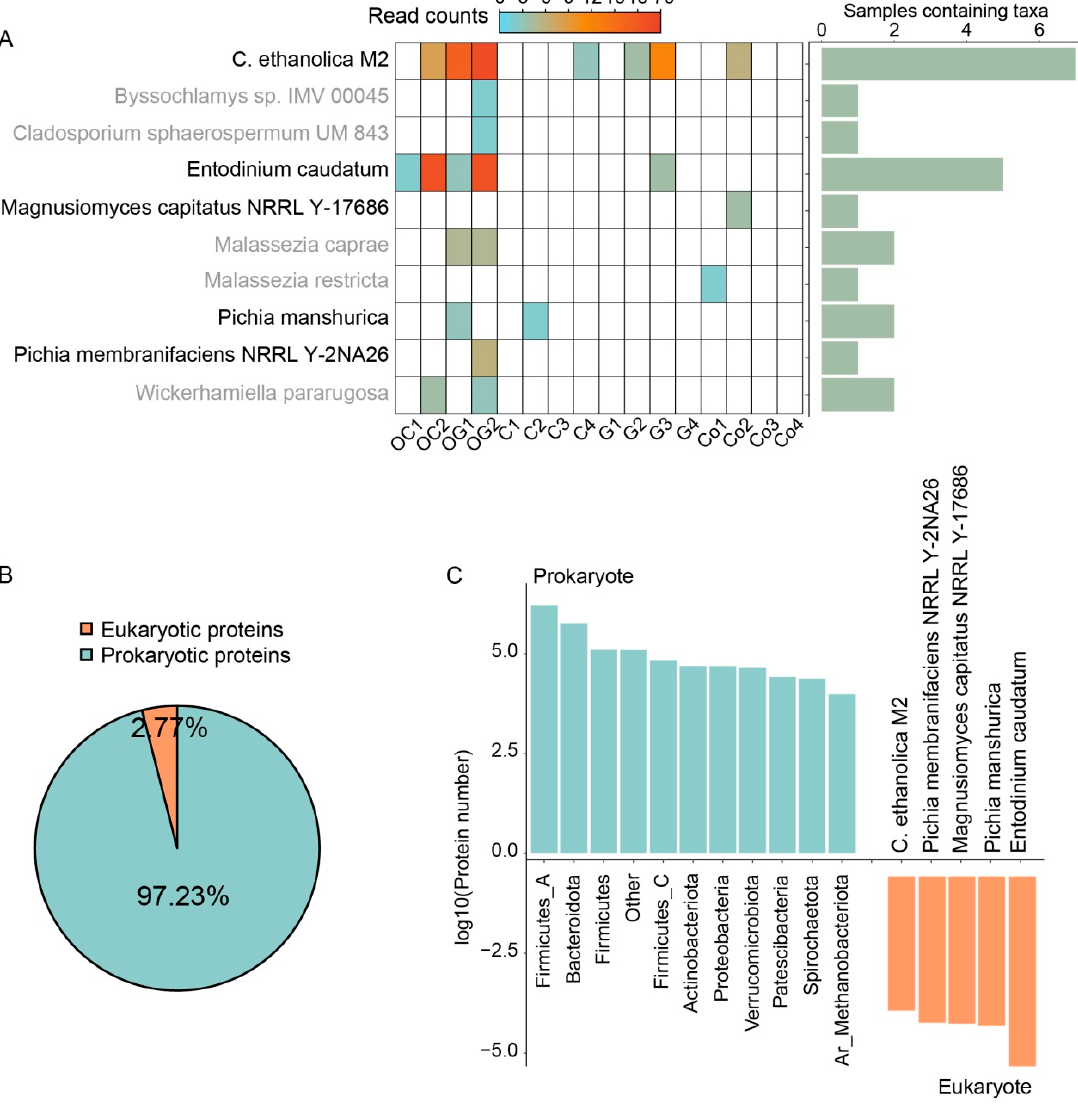
Figure 1. Construction of a rumen-specific protein database containing eukaryotes based on metagenomic data of in vitro fermentation broth. ( A ) The eukaryotic reads contained in the metagenomic data, the heatmap on the left is the read counts of the corresponding species in each metagenomic data, and the histogram on the right is the number of samples containing corresponding species. ( B ) The proportion of eukaryotic and prokaryotic protein sequences in the sample-specific database. ( C ) Distribution of prokaryotic protein sequences at the phylum level and eukaryotic sequences at the species level.